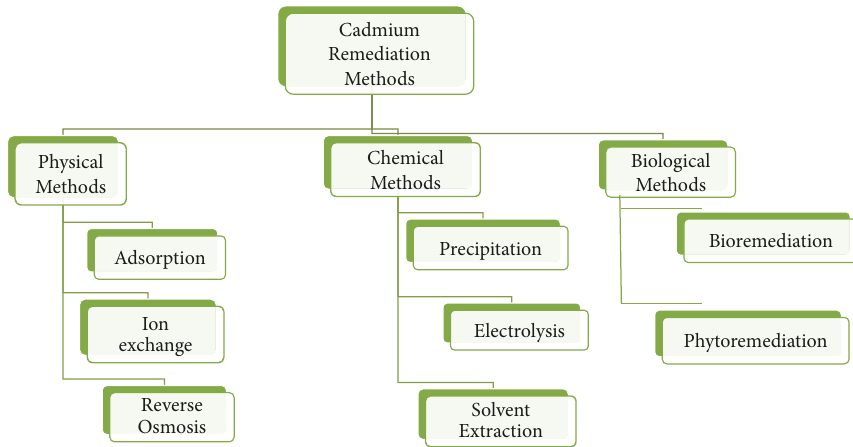
Figure 3: Flowchart of various methods used in Cd